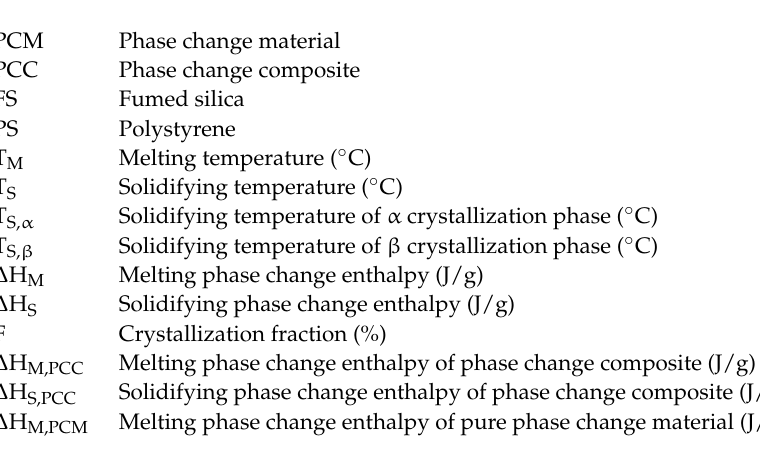
octadecane mass fractions from the leakage test, Figure S3: Thermogravimetric analysis (TGA) curves of the 70 wt% n-octadecane/FS PCC before and after the leakage